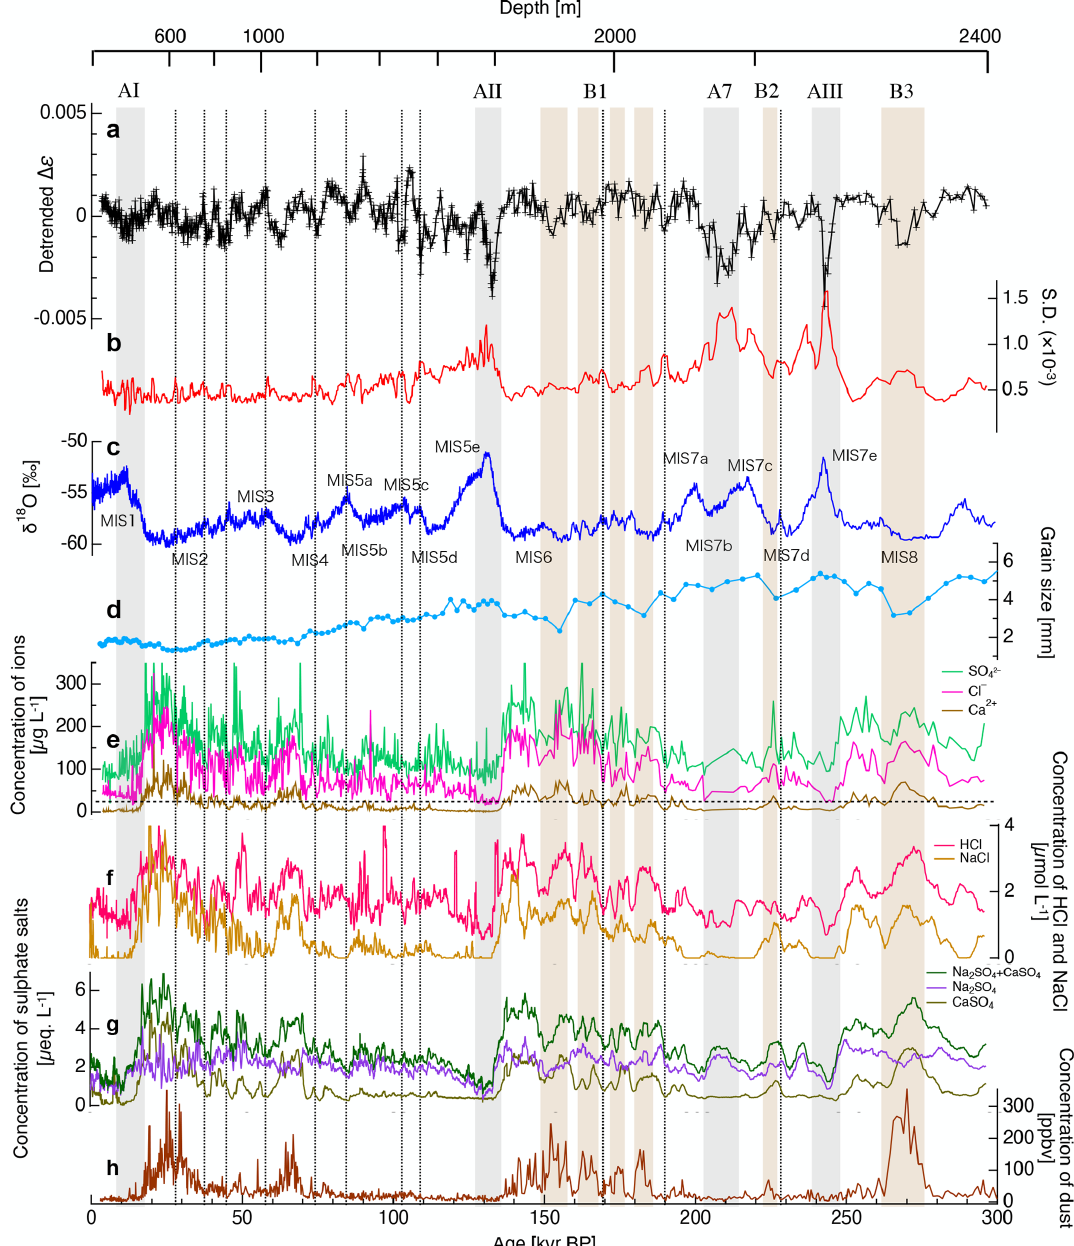
Figure 10. Comparison of detrended (cid:49)ε values with other data from the DF1 ice core. Plots of (a) detrended (cid:49)ε, (b) SD of (cid:49)ε with 10m smoothing, (c) δ 18 O (Dome Fuji Ice Core Project Members, 2017), (d) grain size (Azuma et al., 2000), (e) concentrations of Cl − , SO 2 − Ca 2 + ions (Goto-Azuma et al., 2019), (f) concentrations of HCl and NaCl, (g) concentration of sulfate salts ( ∼ 5m smoothing) (Iizuka et al., 2012), and (h) concentration of dust particles (Dome Fuji Ice Core Project Members, 2017) as functions of ice age. Gray shading indicates correlations between the large depressions in the detrended (cid:49)ε values and lower concentrations of soluble impurities (defined as type A). These regions correspond to the termination I/MIS1 (AI), termination II/MIS5e (AII) and termination III/MIS7e (AIII) transition periods and to MIS7abc (A7). Note that the labels indicate the termination or MIS stage in each case. Brown shading indicates correlations between the depressions in detrended (cid:49)ε values and higher concentrations of dust (defined as type B, numbered in order according to increasing depth). The vertical dotted lines in the plots indicate small increases in the SD values corresponding to Antarctic isotope maxima in terms of δ 18 O and decreased levels of Cl − . The horizontal dashed line in plot (e) indicates the minimum Cl − concentration.